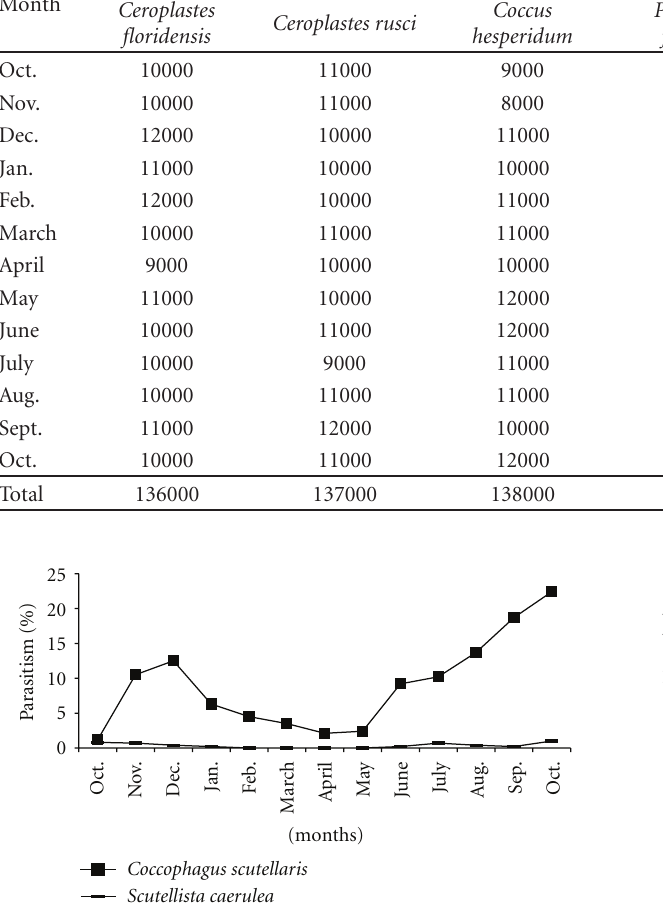
Figure 7: Percent parasitism of Coccophagus scutellaris and other associated parasitoid of Pulvinaria floccifera on mango in Sharqiya governorate after releasing during 2009-2010.